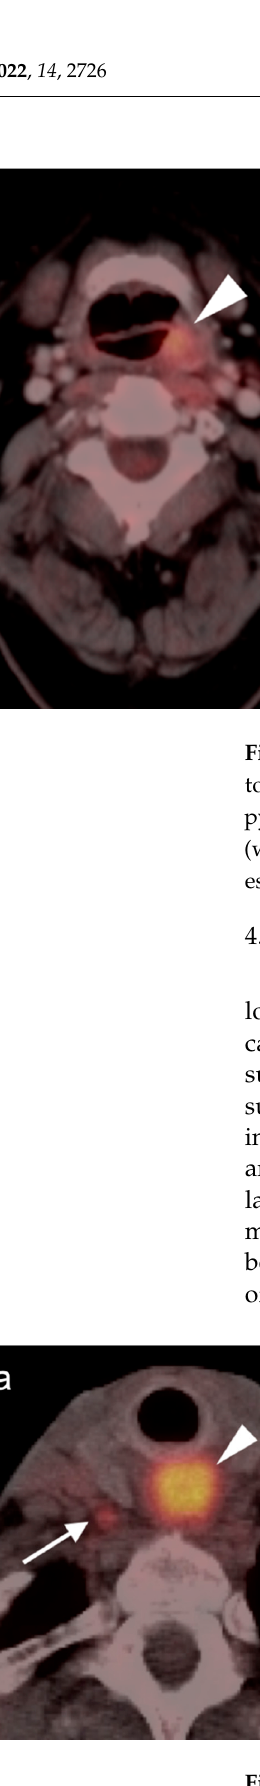
14 of 53 Figure 14. Bilateral oral cavity squamous cell carcinoma of the tongue. ( a ) Right oral tongue squa ‐ mous cell carcinoma (white arrow) and left glossotonsillar primary with spread into the oral tongue (white arrow); ( b ) There is spread to rounded hypermetabolic right anterior submandibular and bilateral level 2A cervical nodes (white arrowheads). 3. Hypopharyngeal squamous cell carcinoma Most hypopharyngeal squamous cell carcinomas are clinically silent until advanced. Five ‐ year survival with small (T1 ‐ 2) lesions is about 60% but all ‐ stage 5 ‐ year survival is only 30% [22]. The hypopharynx is bounded superiorly by the oropharynx (at the level of the hyoid bone) and inferiorly by the cervical esophagus (at the lower margin of the cri ‐ coid cartilage). The sub regions of the hypopharynx include the pyriform sinuses (paired), the post cricoid region and the posterior pharyngeal wall (from the hyoid to the bottom of the cricoid). Tumors are typically markedly FDG avid (Figure 15). Spread of tumor from the posterior pharyngeal wall typically extends first to the retropharyngeal space, then to the prevertebral space, with increased incidence of pathologic retropharyngeal lymph nodes. SCC of the post ‐ cricoid region is often insidious in onset. Tumor arising in the post ‐ cricoid region may spread anteriorly to the cricoid cartilage and larynx, superiorly to the base of tongue and inferiorly to the cervical esophagus. Spread of tumor from the pyri ‐ form sinuses often extends laterally to involve the thyroid cartilage, lateral soft tissues, and anterior cervical neck nodes, the latter often being clinically occult [23]. Imaging is critical is management of hypopharyngeal tumors, with critical factors being extension to the base of the tongue, the cervical esophagus, posterior prevertebral space invasion, and cricoid cartilage invasion. Although identification of nodal disease is important, 60% of early T ‐ stage hypopharyngeal tumors have microscopic disease in lymph nodes, unlikely